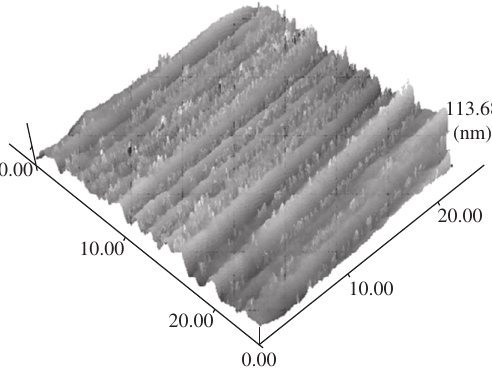
Figure 8. AFM image of ternary SiO 15 minutes.